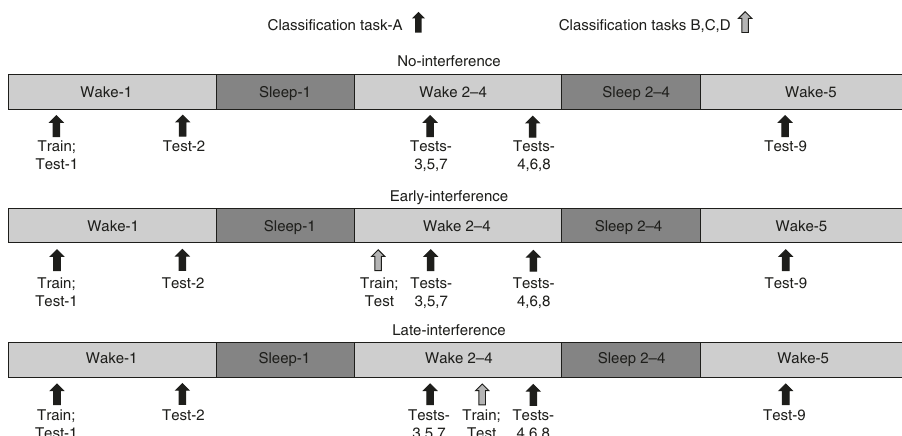
Fig. 3 Experimental design for experiment-2. Twenty-four starlings were trained to classify 5 s segments of novel starling song. Starlings were trained on classi fi cation task-A from 10:00 a.m. to 12:00 p.m. and tested nine times thereafter: at 12:00 p.m. and 6:00 p.m. on days 1 – 4 and again at 12:00 p.m. on day-5. In the interference conditions, starlings also were trained and tested on classi fi cation task-B (on day-2), task-C (on day-3), and task-D (on day-4), either in the morning from 7:00 a.m. to 10:00 a.m. before task-A was tested (early-interference) or in the afternoon from 1:00 p.m. to 4:00 p.m. after task- A was tested (late-interference). The interference tasks (B, C, and D) entailed the same Go/No-Go operant training and testing procedure as task-A, but each task utilized different pairs of novel song stimuli. Each starling completed all three